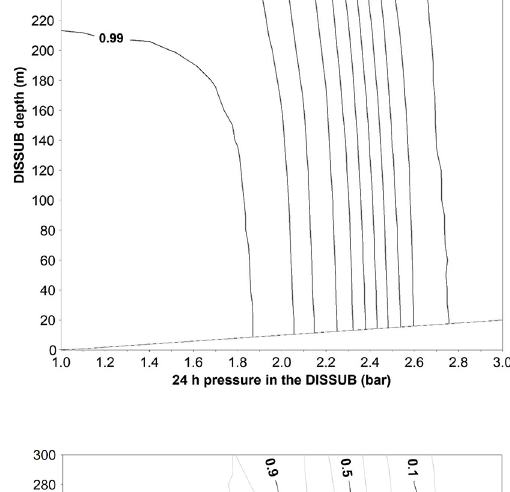
Figure 2. Probability of survival curves for an 80kg individual for escape following 24h at raised DISSUB pressure (black); 95% con fi dence regions for each contour